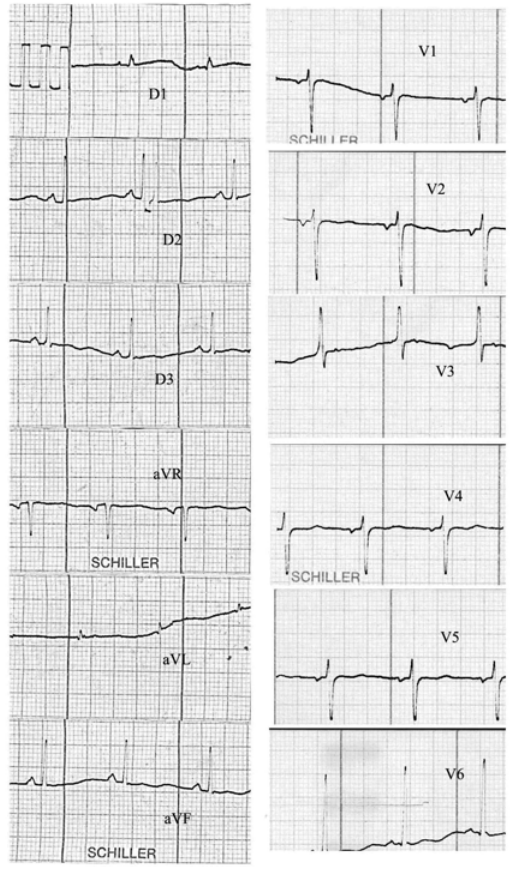
FIGURE 1 . Diffuse, flattened T wave and prolongation of QT interval. Amputate (low) voltage R wave in leads V4, V5. Pathologic terminal forces of P wave in lead